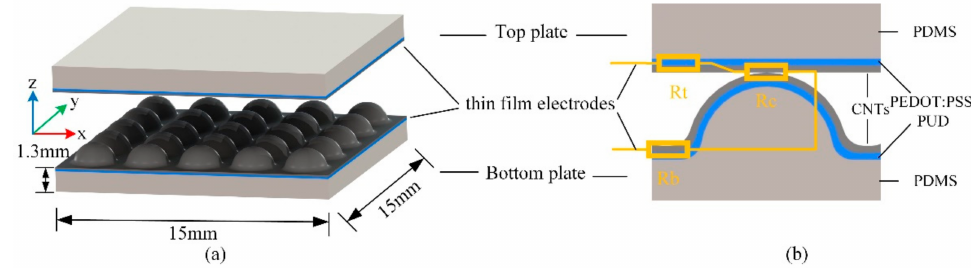
Figure 1. The proposed pressure sensor: ( a ) basic structure; ( b ) simplified sensor